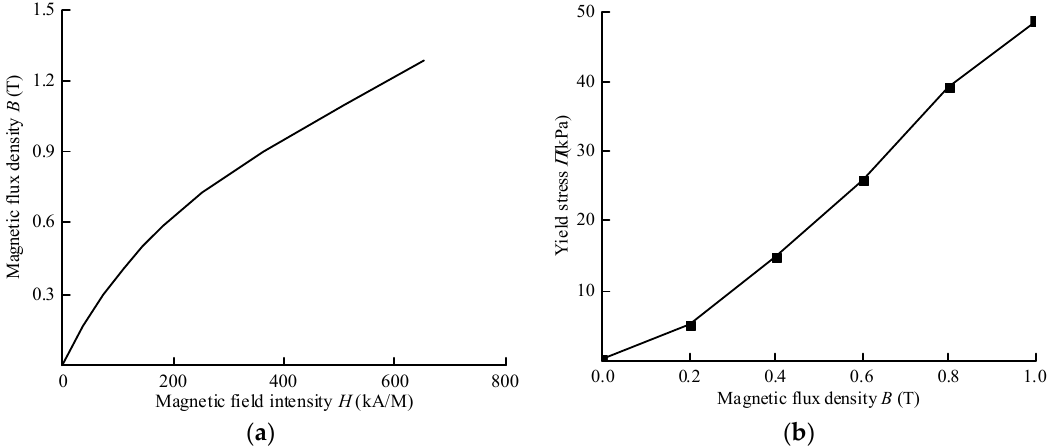
Figure 4. The performance curves of MR fluids: ( a ) B - H curve; ( b ) τ –B curve.